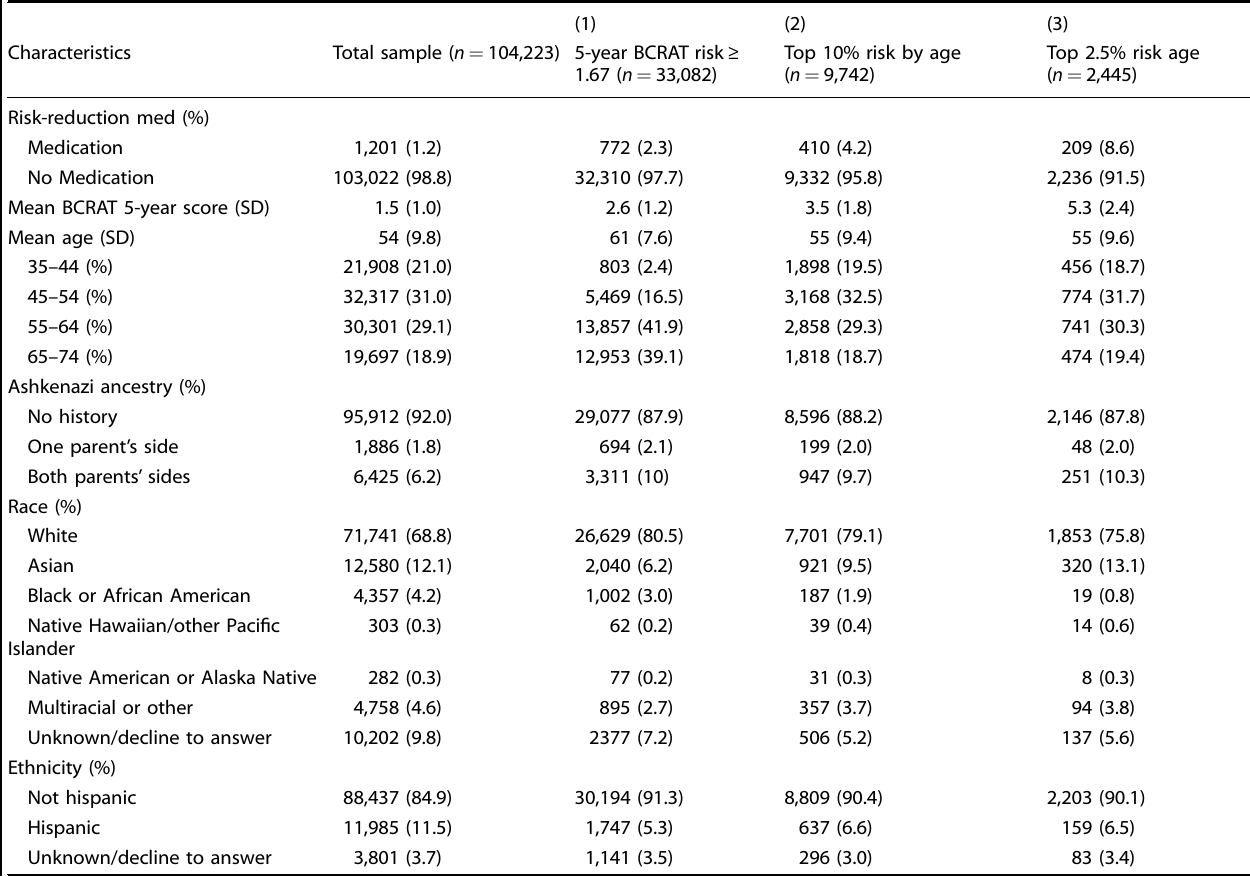
Table 1. Selected characteristics of the Athena Breast Health Network Screening